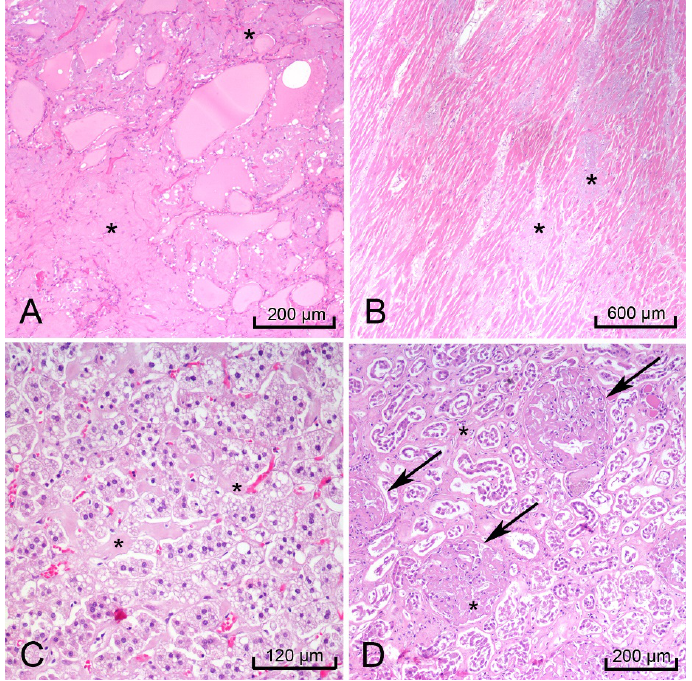
Figure 3. Images of hematoxylin & eosin (H&E) stained organs with hyaline extracellular matrix (black *) that indicated amyloidosis. Thyroid ( A ), heart, left ventricle ( B ), right adrenal gland ( C ), and right kidney (black arrows glomeruli) ( D ).